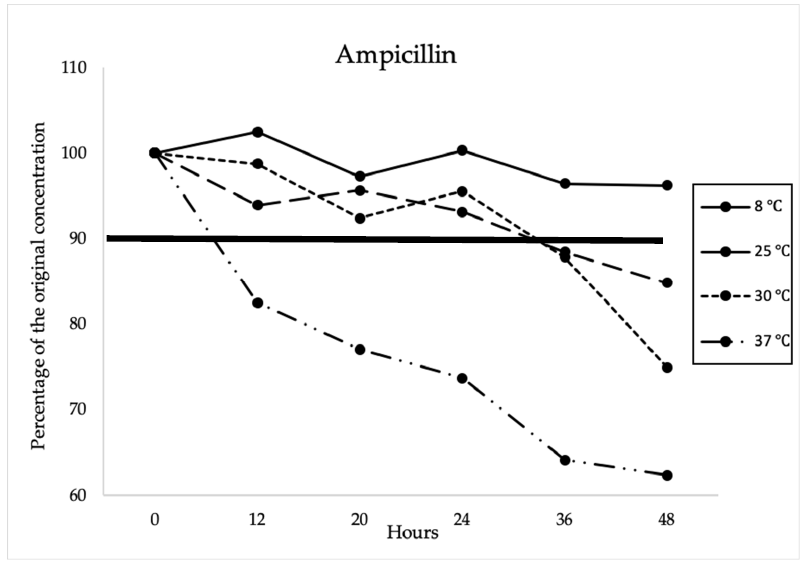
Figure 1. AMP stability expressed as mean percentage of original concentration over time at 8 °C ± 2 °C, 25 °C ± 2 °C, 30 °C ± 2 °C and 37 °C ± 2 °C. Dashed line indicates 90% of residual ratio.